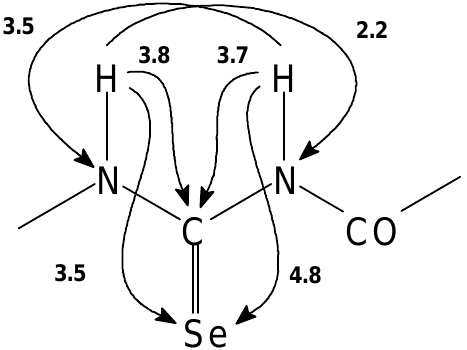
Figure 1. The nonoptimized long range 1 H- 13 C, 1 H- 15 N and 1 H- 77 Se interactions [Hz] observed for basic skeleton of acylselenourea 1